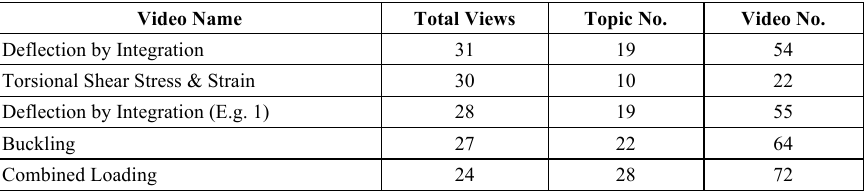
Table 4. A collection of videos with highest view counts throughout the semester. Video Name Total Views Topic